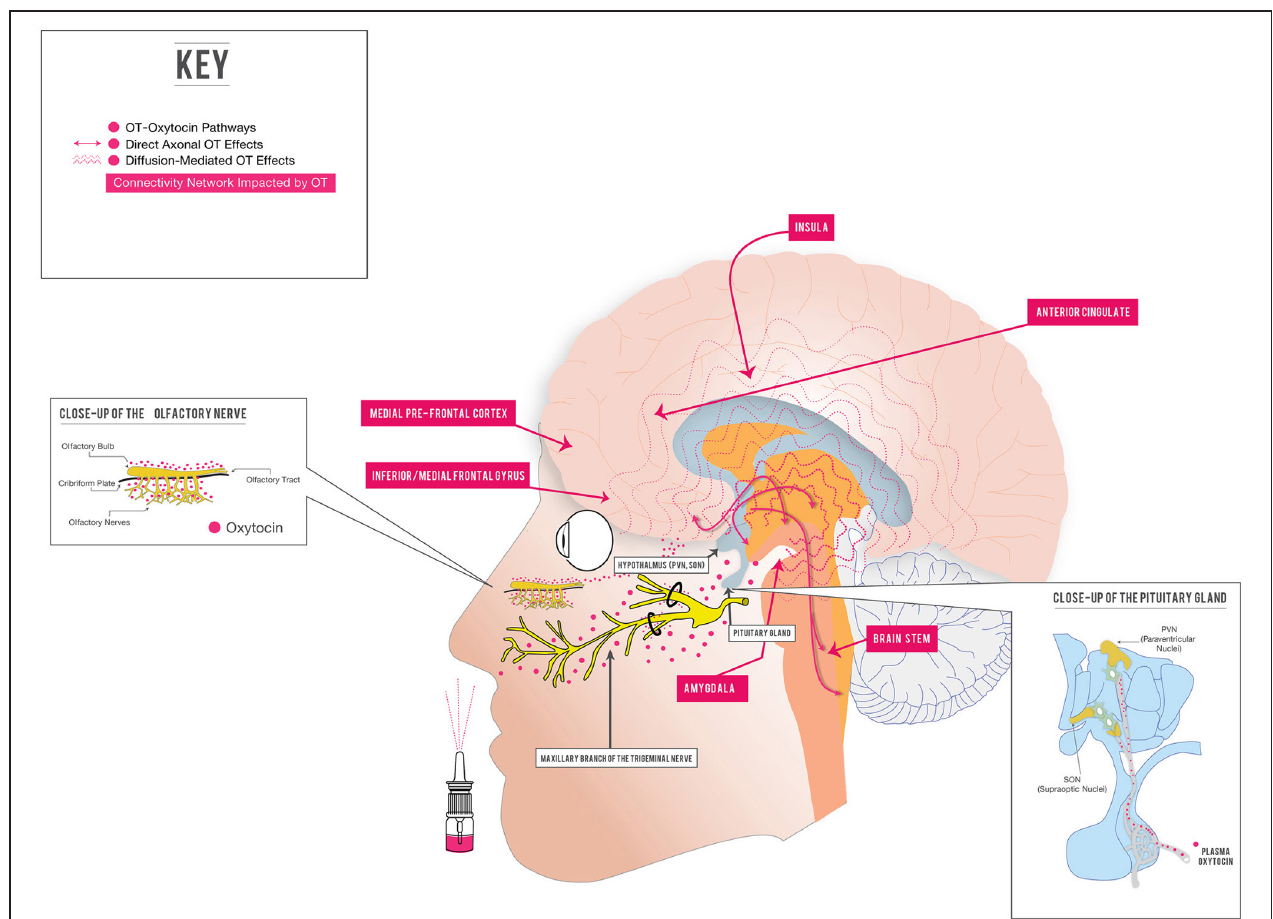
FIGURE 1 | Intranasal oxytocin: potential therapeutic regulation of brain function in psychiatric illness. Several important aspects of intranasally delivered OT (IN OT) treatment of brain-based illness are represented. One potential way that IN OT may cross the blood-brain barrier and cause central effects is represented: directly via extraneuronal/perineuronal routes along trigeminal or olfactory nerve pathways (Thorne and Frey, 2001; Ross et al., 2004; Dhuria et al., 2010; Renner et al., 2012a,b). Other mechanisms of entry (bulk flow, lymphatic channels, intraneuronal transport, active or passive transport from vasculature) are discussed in references and the text. IN OT may cause some of its central effects by stimulating the